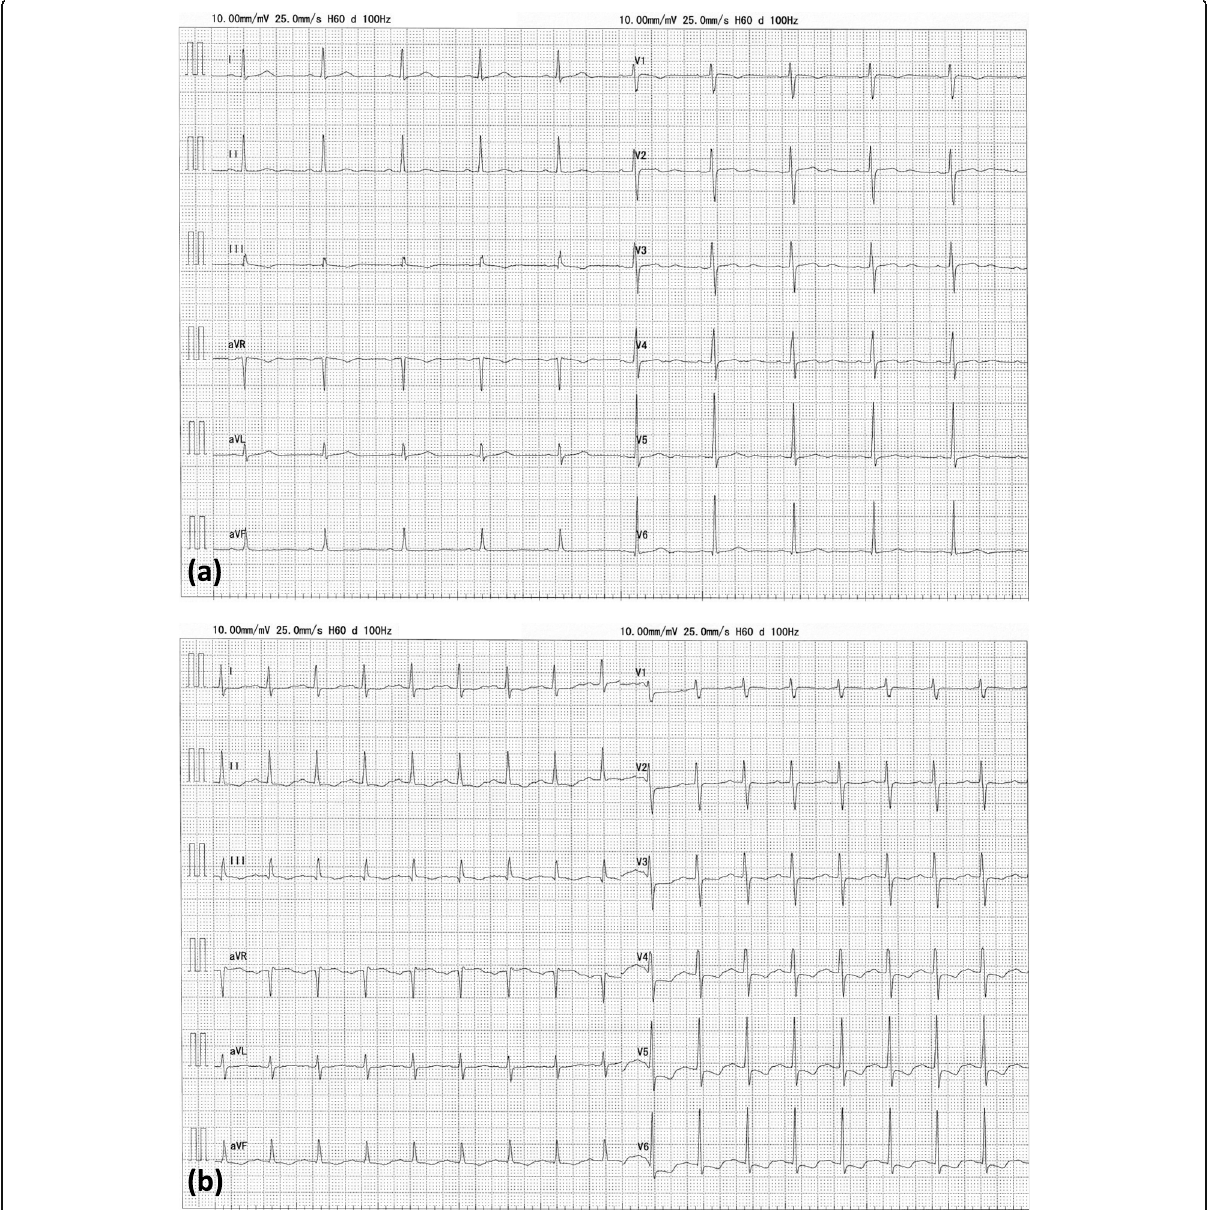
Fig. 1 Twelve-lead ECG (electrocardiogram) taken before surgery and at arrival at the intensive care unit (ICU). The preoperative ECG ( a ) showed sinus rhythm (heart rate 62 bpm) with no abnormality. The ECG at arrival at ICU ( b ) showed sinus rhythm (heart rate 102 bpm), whereas it revealed downsloping ST depression in leads II, III, aVF, and V3-6, as well as, ST elevation in lead